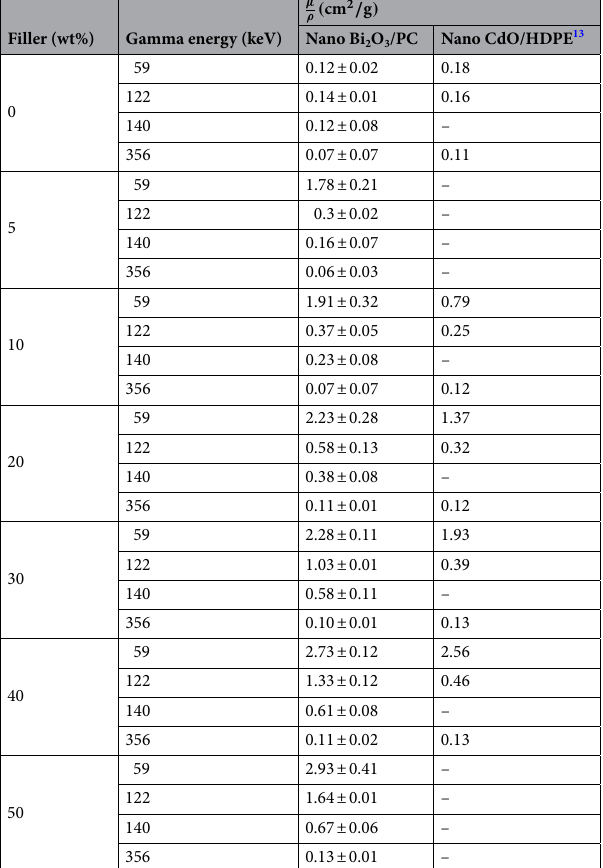
with the other researches 34,35 .